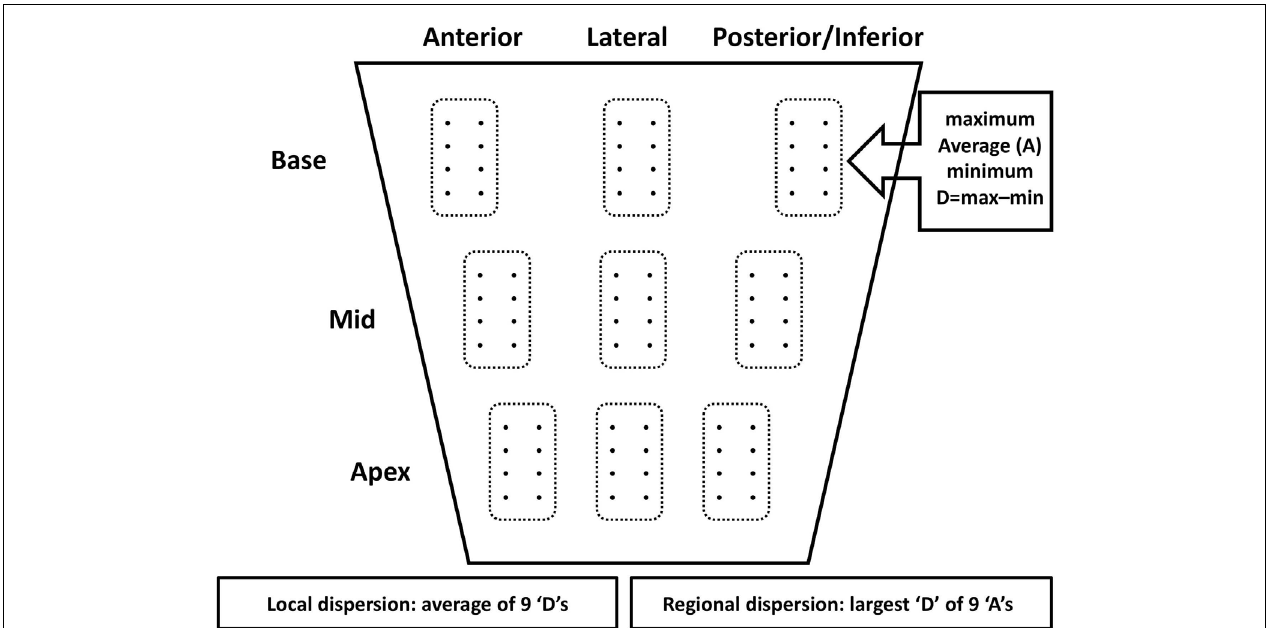
minimum) were determined for activation times, activation-recovery intervals and repolarization times. Local dispersion was defined as the average of the 9 “ D ” values. Regional dispersion was defined as the difference between the largest and smallest “A” (see Materials and Methods for further explanation).